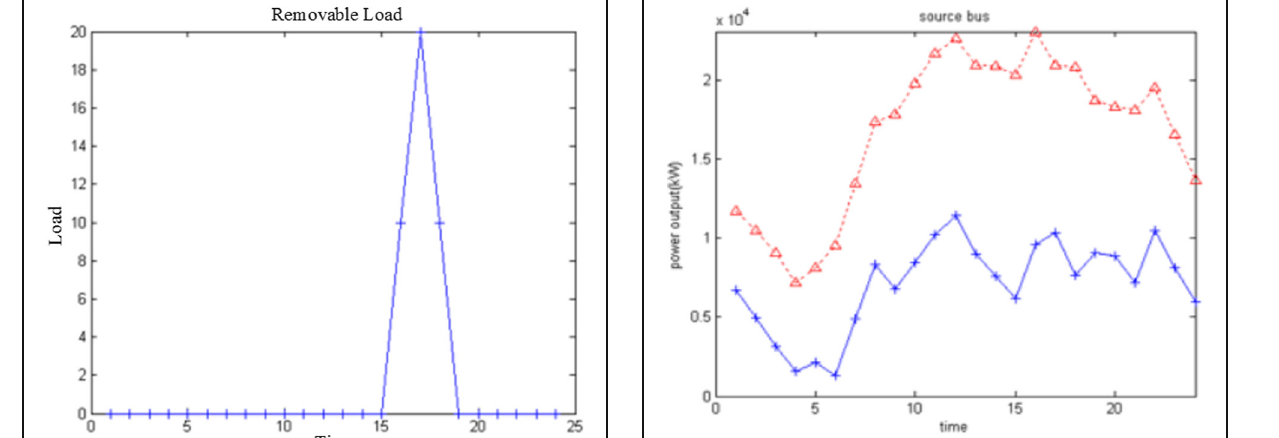
Fig. 13 Active power schedules of the source bus